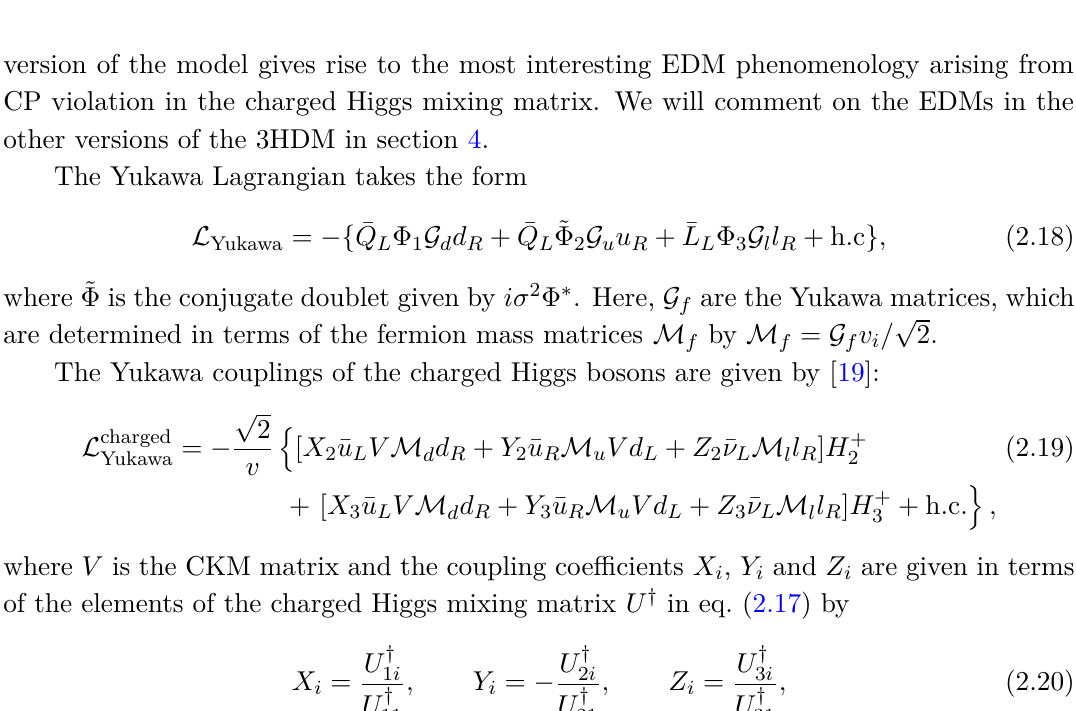
Table 2 . Coefficients X i , Y i , and Z i appearing in the Yukawa Lagrangian for the H + down-type quarks, up-type quarks, and (charged) leptons, respectively, with i = 2 , 3 . The matrix U † is defined in eq.